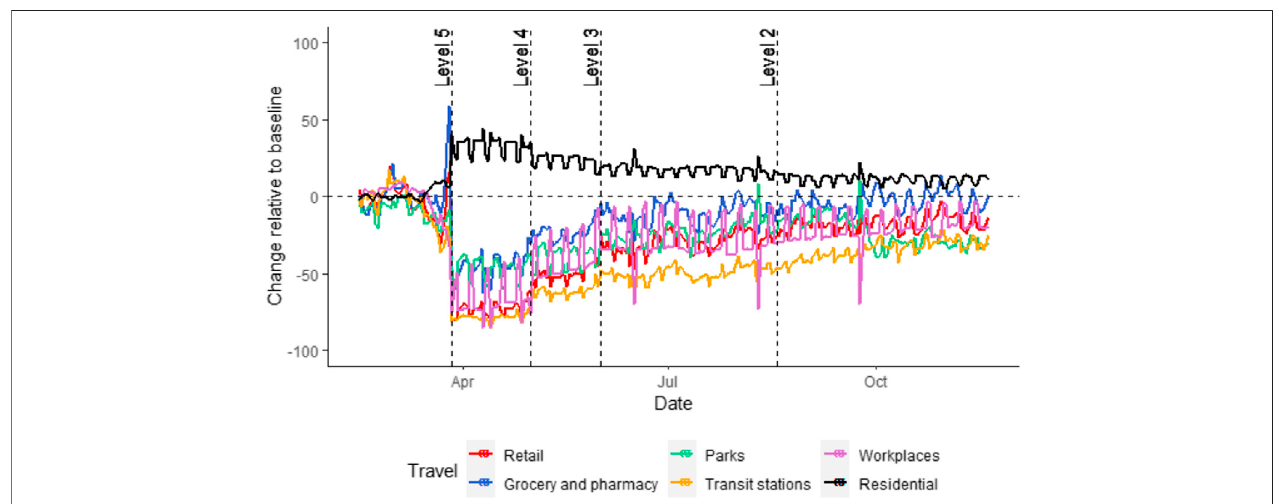
Frontiers in Big Data |